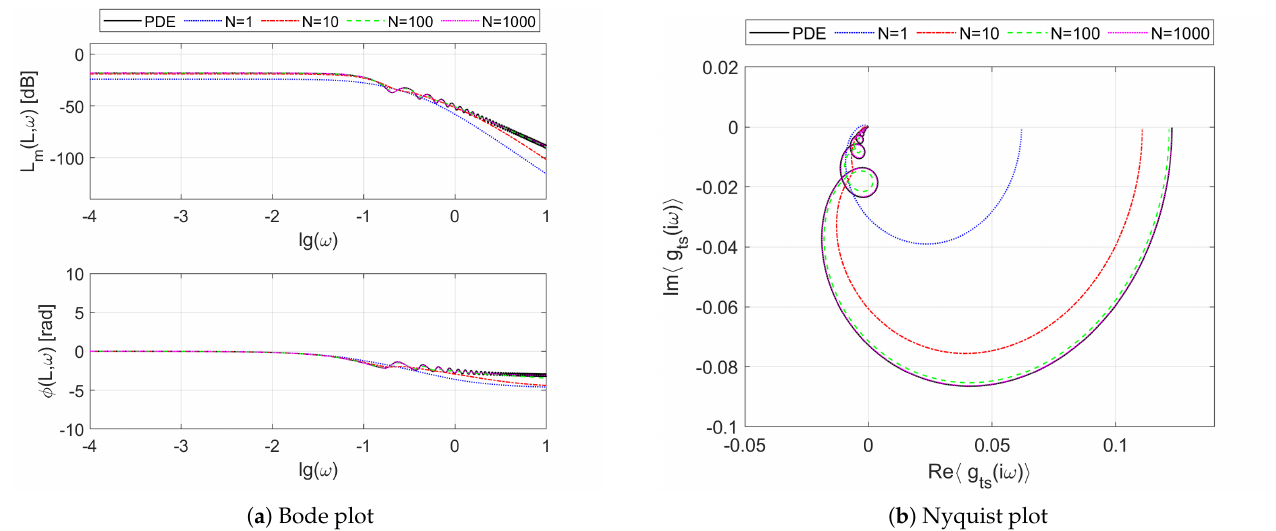
Figure 4. Frequency response g ts ( L , i ω ) of the irrational transfer function model of the double-pipe counter-flow heat exchanger vs. frequency responses ˆ g ts ( l N , i ω ) of its approximate rational transfer function models for different values of N .